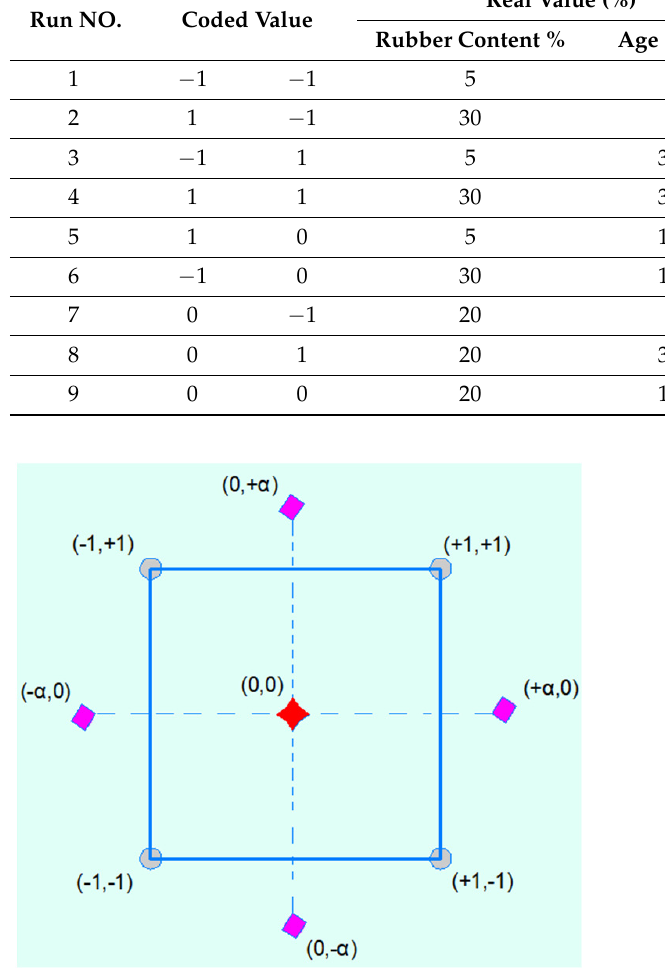
Table 5. Required experimental run according to CCD for all data sets. Real Value (%) CCD Run NO. Coded Value